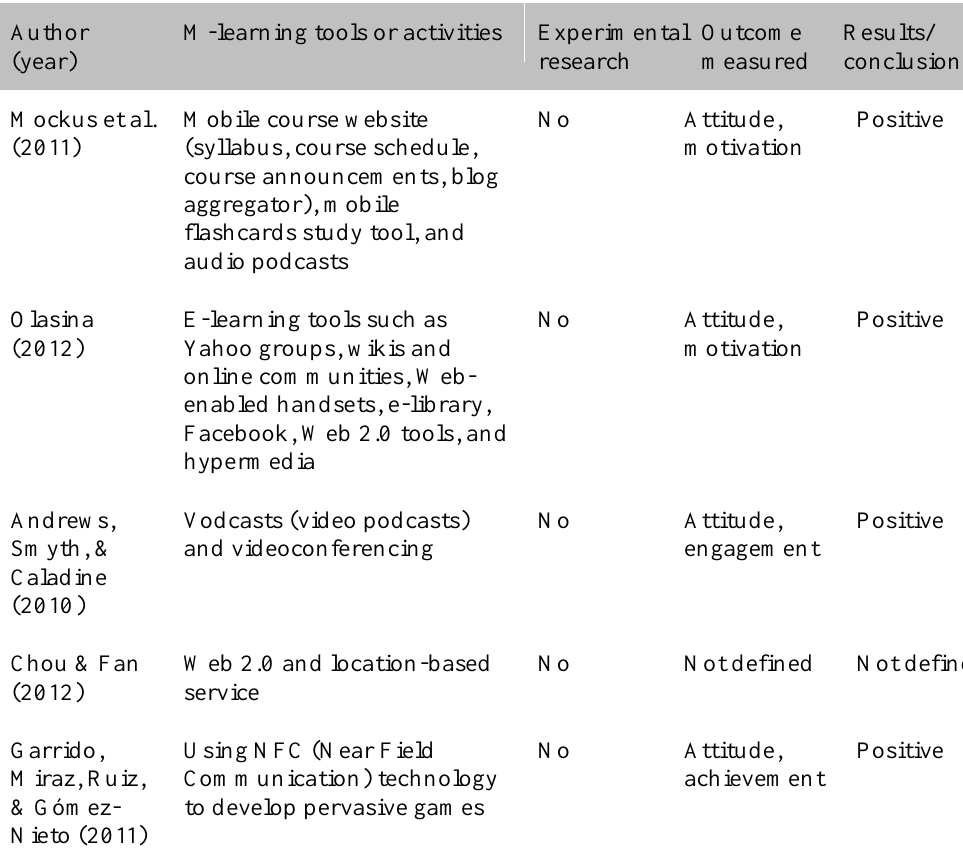
Research on Motivation in Mobile